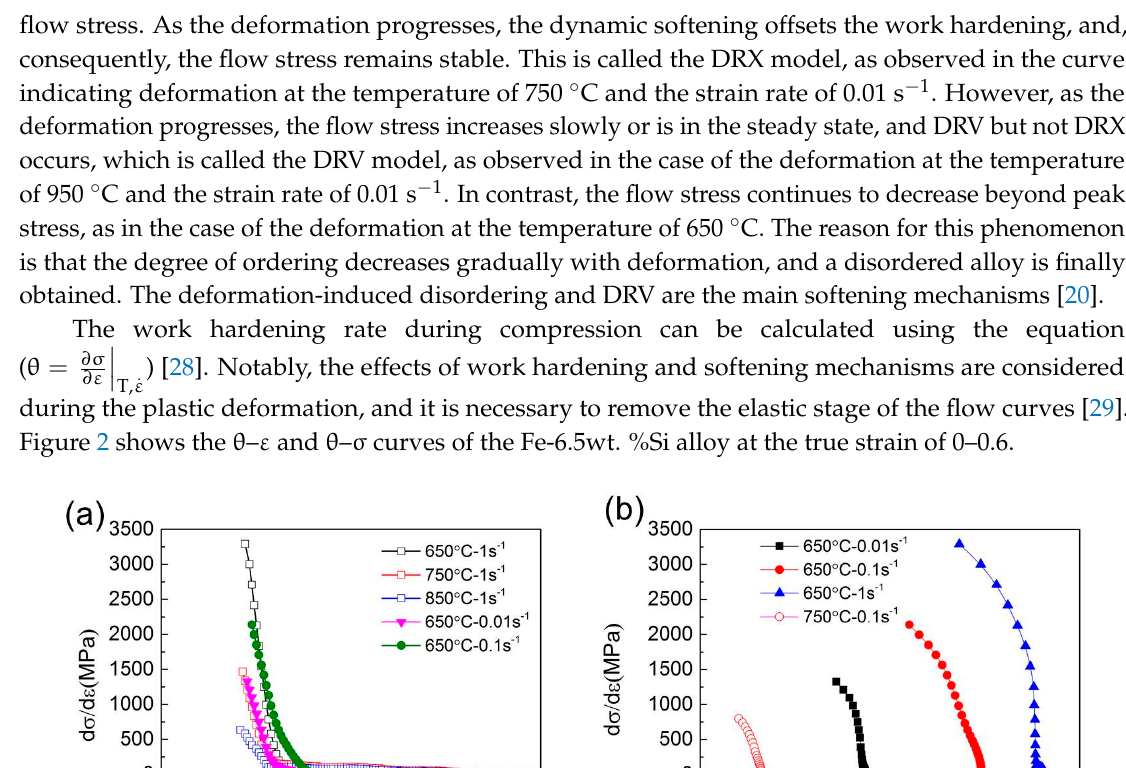
Table 2. Peak stress (MPa) and corresponding strain of the Fe-6.5wt. %Si alloy.